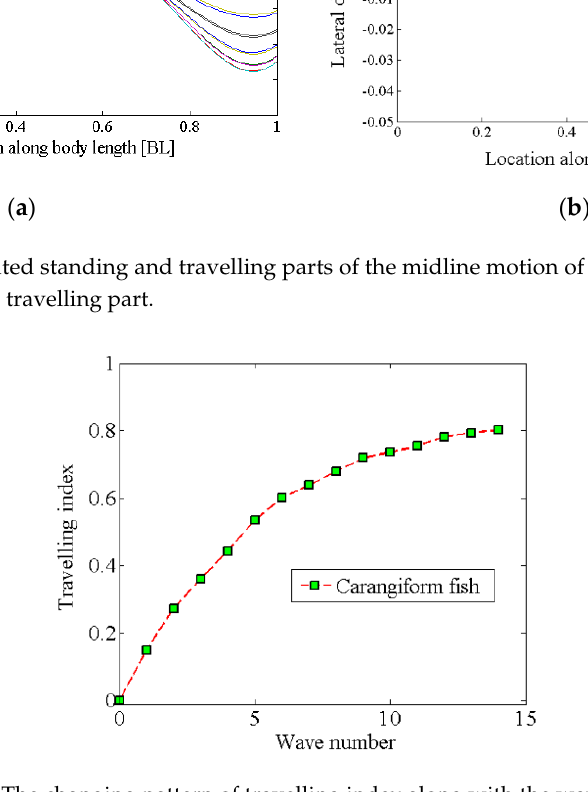
Figure 9. The separated standing and travelling parts of the midline motion of the carangiform fish. ( a ) standing part; ( b ) travelling part.